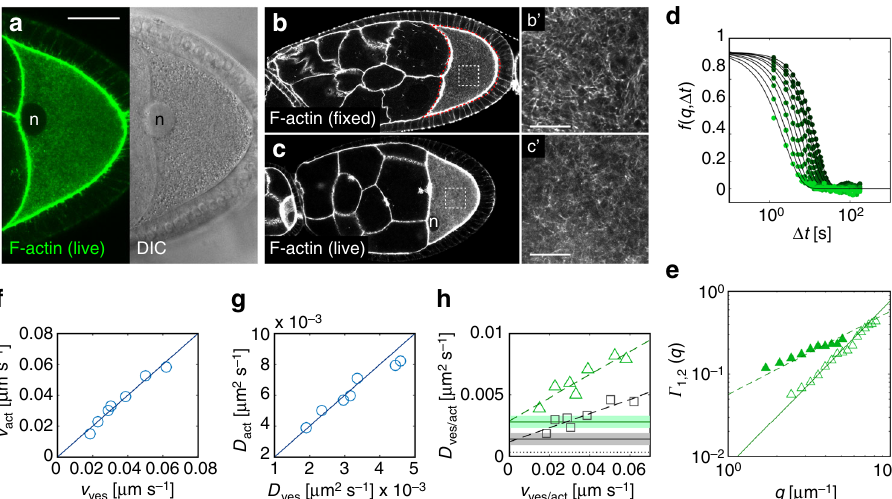
Fig. 2 The motion of cytoplasmic F-actin directly correlates with the motion of vesicles. a Confocal image of F-actin stained by UTRN.GFP (left panel). DIC image of the same oocyte (right panel). n nucleus. Scale bar is 30 µ m. b Distribution of F-actin (stained with TRITC-phalloidin) in a fi xed st9 egg chamber. b ′ High magni fi cation of cytoplasmic F-actin (white box in b ). c UTRN.GFP-expressing living egg chamber. UTRN.GFP labels the same structures as phalloidin in fi xed samples (compare to b ). c ′ High magni fi cation of cytoplasmic F-actin in a UTRN.GFP-expressing living oocyte (white box in c ). b ′ , c ′ Scale bars represent 10 µ m. d Intermediate scattering functions (ISF) f ( q , Δ t ) obtained from Con-DDM analysis for different wave vectors q in the range 2 µ m − 1 < q < 8 µ m − 1 . Continuous lines are best fi t to Eq. (1). e Decorrelation rates Γ q ) (solid triangles) and Γ q ) (open triangles) obtained from the fi t of 1 ( 2 ( the ISF, represented in d . Dashed line constitutes the best fi t of Γ 1 ( q ) to a linear function Γ 1 ( q ) = v act q . Continuous line is obtained from the fi t of Γ 2 ( q ) to a quadratic function Γ 2 ( q ) = D act q 2 . f F-actin mean speeds ( v act ) plotted against vesicle mean speeds ( v ves ) with each data point corresponding to one